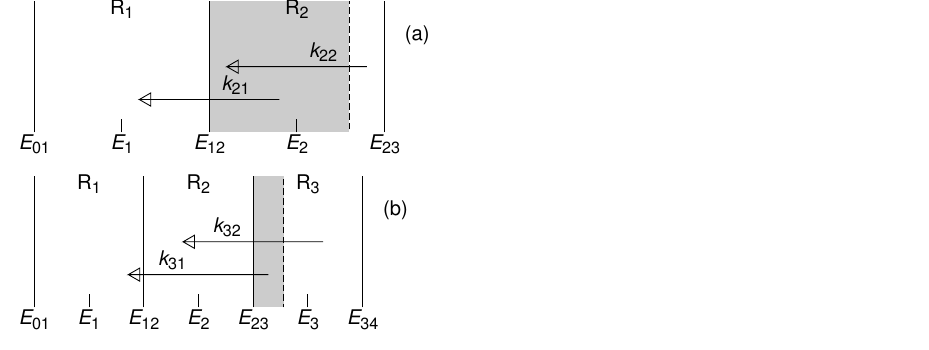
Figure 1. Electron energy losses (arrows) in relation to electron–energy subranges: ( a ) For an energy transition ε that is less than the subrange size E 23 − E 12 , electrons with initial energies in the shaded area cross the boundary to range R 1 , while the others remain within range R 2 . ( b ) For ε greater than the subrange size E 34 − E 23 , all electrons transit to a lower subrange, with those in the shaded region going to R 1 and the others to R 2